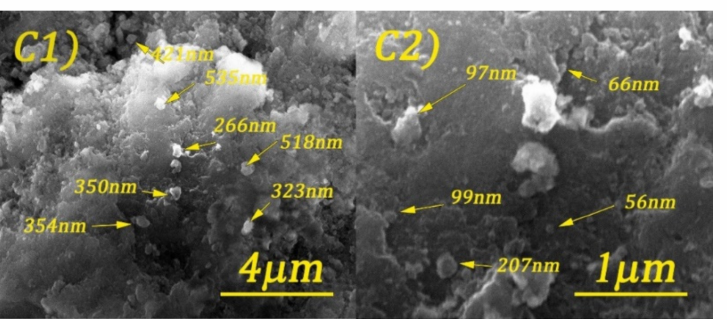
Figure 7. SEM images of CoFe 2 O 4 -0.25 at different magnifications: 20 kX ( C1 ) and 80 kX ( C2 ).